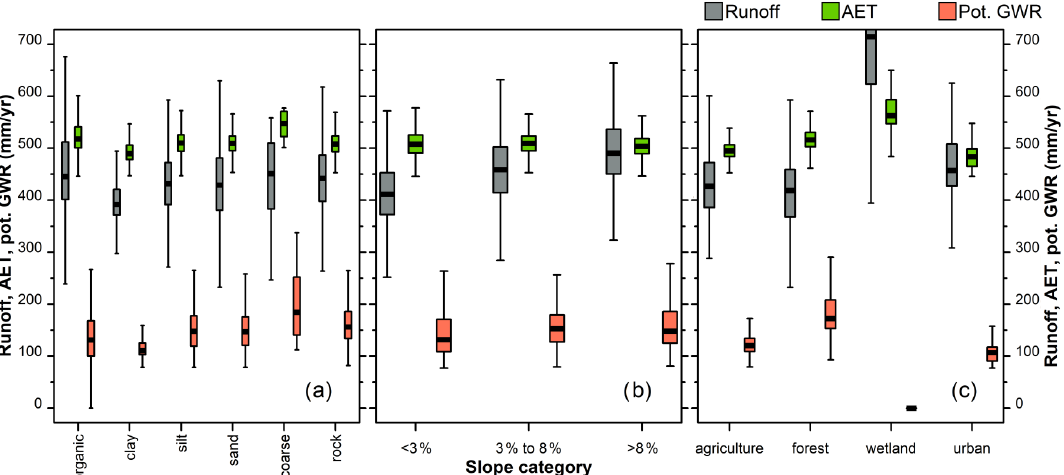
Figure 7. Median, 25th and 75th percentile, minimum, and maximum values for annual runoff, actual evapotranspiration (AET), and potential GWR throughout the study area between 1961 and 2017, classified as a function of (a) soil type, (b) slope, and (c) land cover.